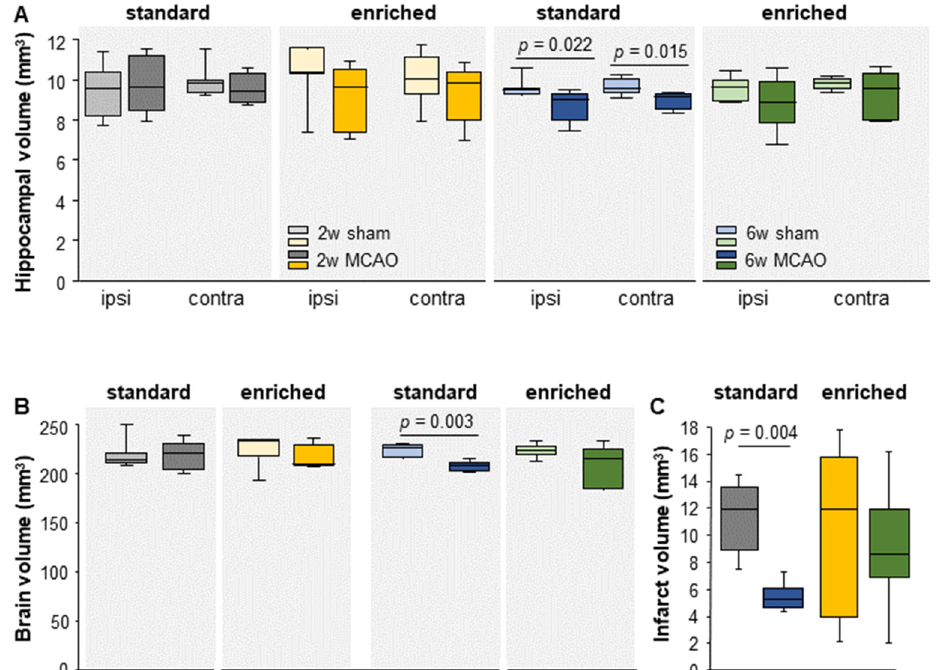
Figure 2. Impact of MCAO and EE on ( A ) hippocampal volume, ( B ) brain volume and ( C ) infarct volume. Significant differences were found in the hippocampal volume between sham and MCAO under standard conditions, both ipsi- and contralateral, 7 weeks post-surgery. The boxplots show the median, upper and lower quartile, and minimum and maximum values. Statistical analyses were performed using the Mann–Whitney U test.